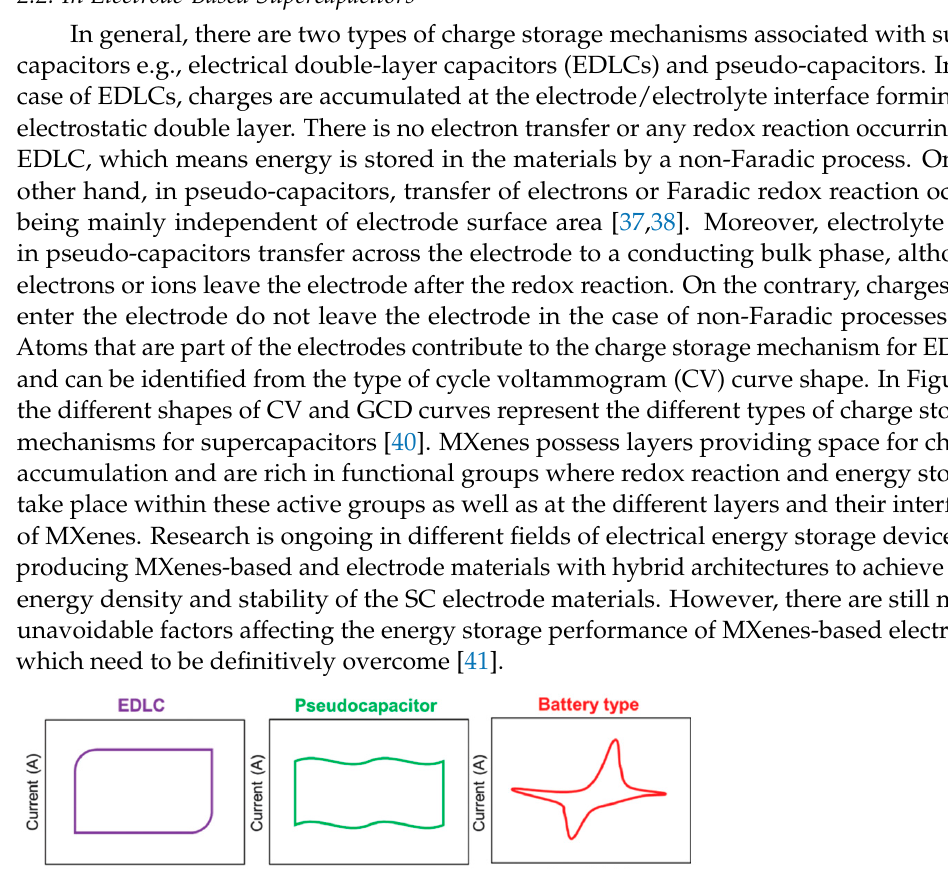
Figure 2. Demonstrative cyclic voltammetry (CV) galvanostatic charge-discharge (GCD) curves of EDLC, pseudocapacitive, and battery-type behaviours. Reprinted with permission from [40]. Cop-